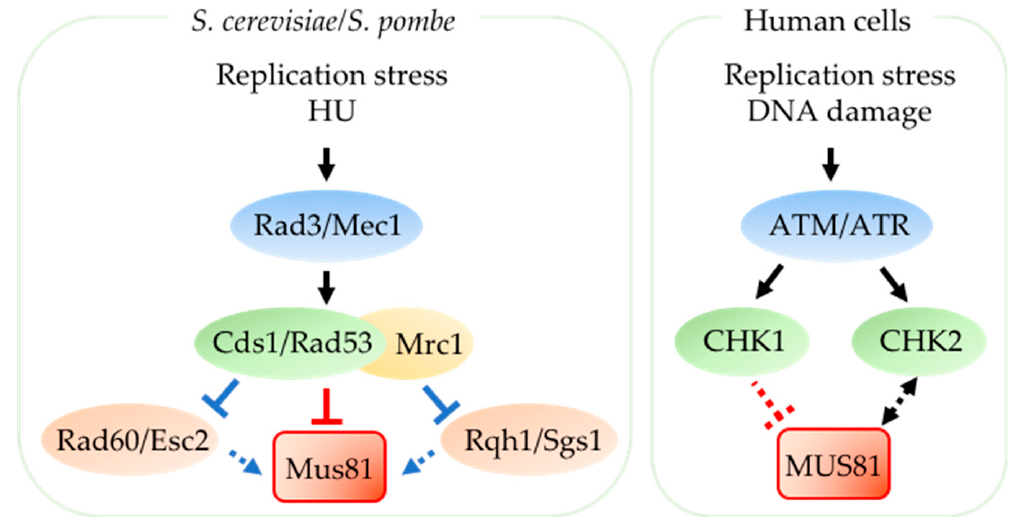
Figure 3. Mus81 regulation by replication checkpoint. In yeast, replication stress induces Rad3 S.p. /Mec1 S.c. (ATR in human) activation of Cds1 S.p. /Rad53 S.c. by promoting its association with Mrc1 S. p./S.c. (CLASPIN in human) (reviewed in [80]). Upon acute and severe replication stress such as hydroxyurea treatment, Cds1 S.p. limits Mus81 S.p. activity (indicated by solid red line) [44]. Cds1 S.p. inhibits Rad60 S.p. activity (indicated by blue line) by promoting delocalization from the nucleus [82,83]. Mrc1 S.p./S.c. protein level regulates recruitment of Rqh1 S.p. homolog Sgs1 S.c. to chromatin (indicated by blue arrow) [74]. Both Rad60 S.p. /Esc2 S.c. and Rqh1 S.p. /Sgs1 S.c. contribute to Mus81 activity (indicated by dashed blue arrow) [75,76]. In human cells, DNA damage checkpoint CHK1 and Cds1-homolog